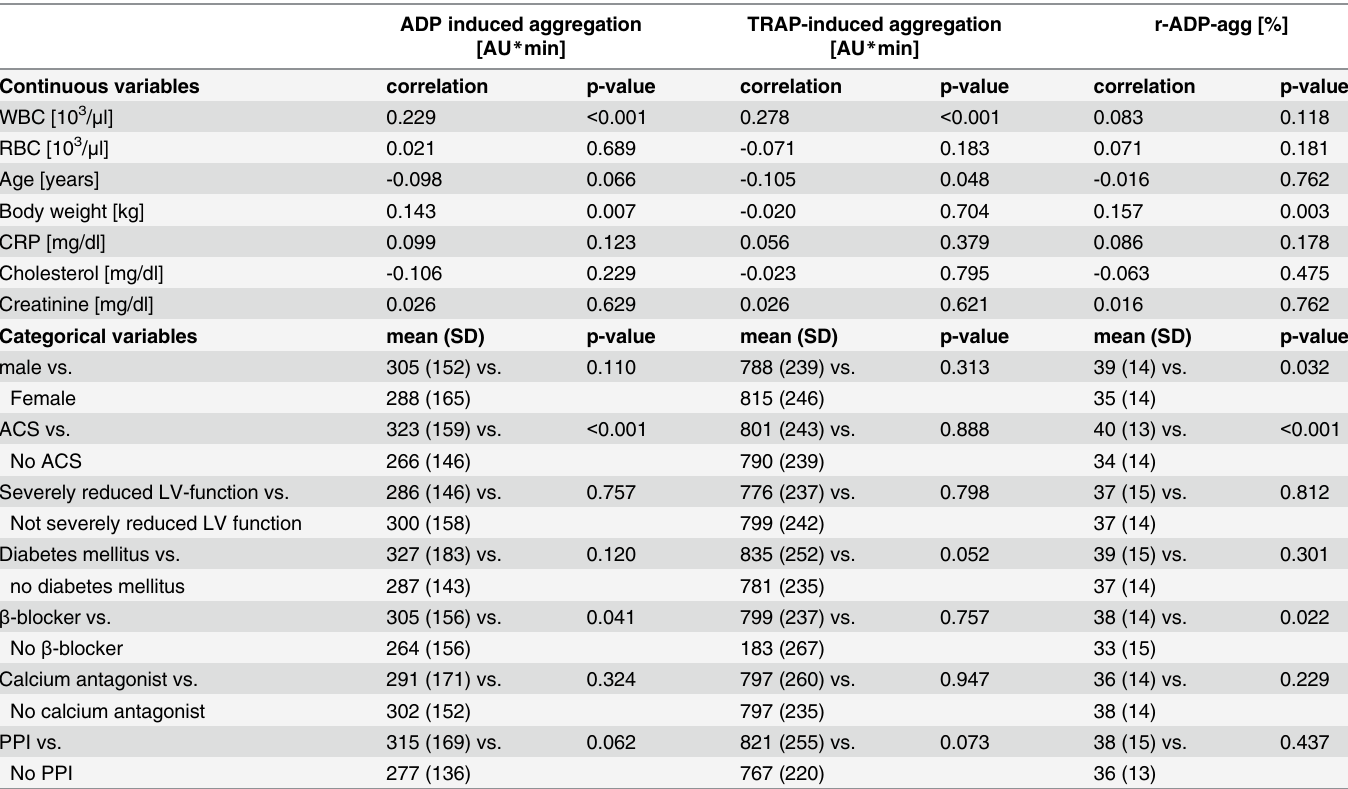
Table 2. Association of patient characteristics with aggregation